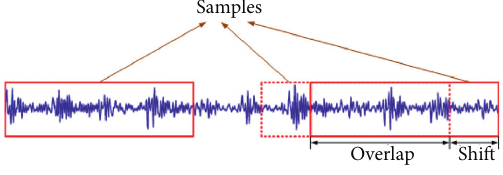
Figure 4: Data augment with